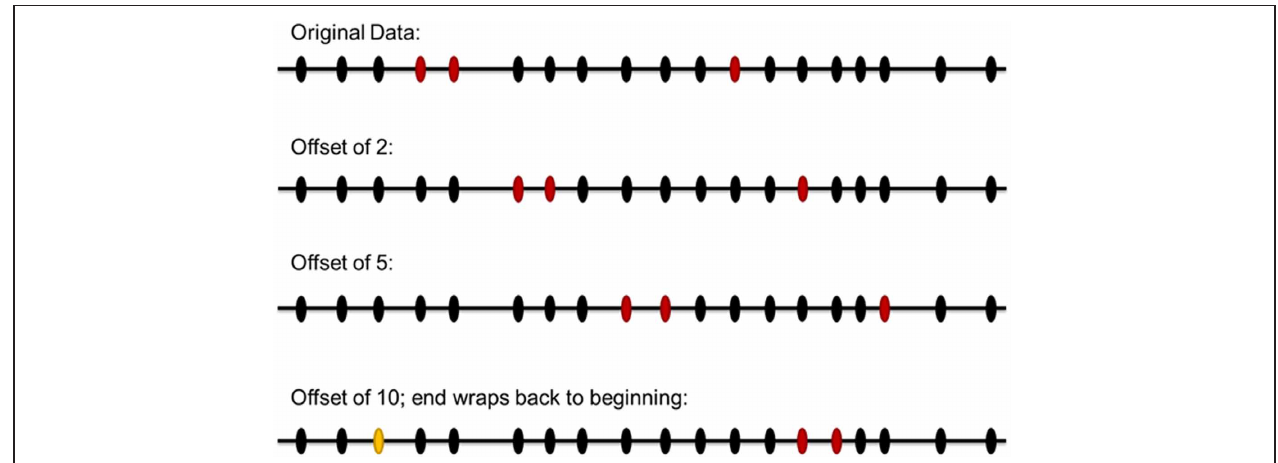
FIGURE 3 | Scheme for simulation to evaluate significance of experimental results. The pattern of the positive SNPs from the original data among the total SNPs passing our quality control was defined. For each simulated dataset, this pattern was offset by a random number between 1 and number of SNPs in the original data. In this illustration of the simulation scheme, 19 SNPs are modeled, with the red ovals indicating SNPs of interest. The top line represents the original data. The next two lines